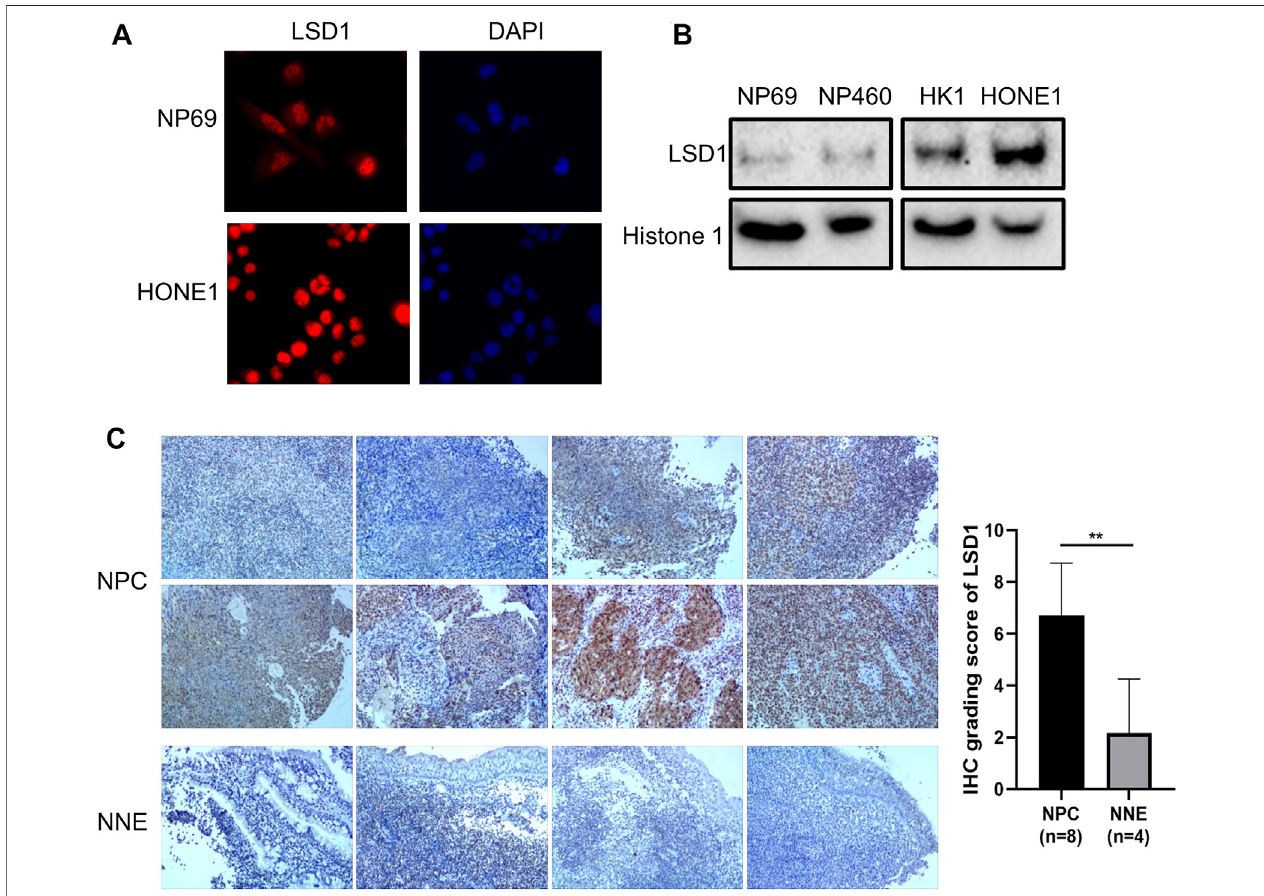
FIGURE 6 | Abnormally increased LSD1 expression in NPC cells. (A) Immuno fl uorescence analysis of LSD1 (red) in NP69 and HONE1 cells. Cellular nuclei were counter-stainedwithDAPI. (B) WesternblotanalysisforLSD1expressionincellularfractionsofNNEversusNPCcelllines.Histone1wasusedasanendogenouscontrol of protein loading for the nuclear fractions. (C) Immunohistochemistry staining of LSD1 in NPC ( n = 8) and NNE tissues ( n = 4).